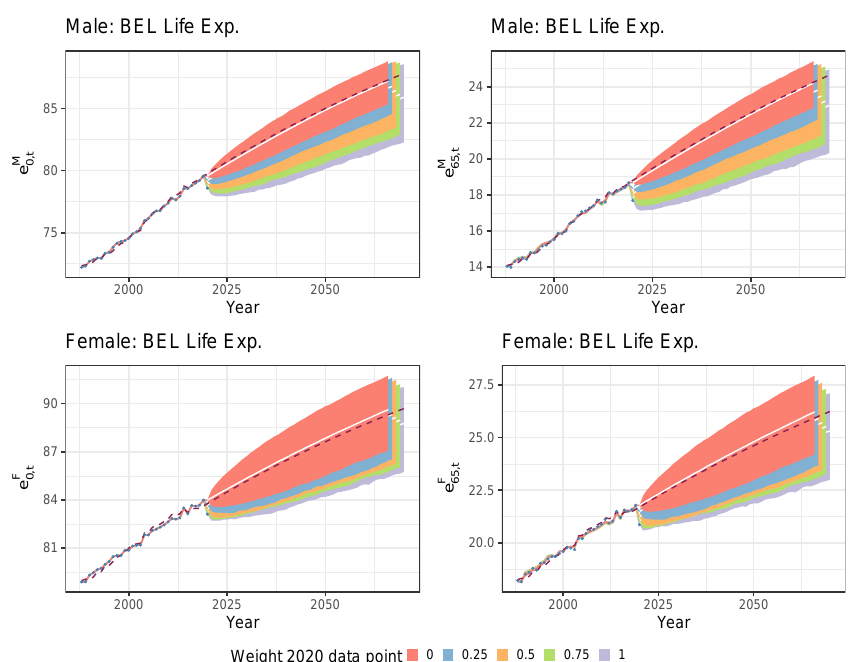
Figure 15. Estimated and projected period life expectancies ˆ e x , t for Belgium. Male ( top ) and female ( bottom ) data, ages 0 ( left ) and 65 ( right ), calibration period 1988–2020, projection period 2021–2070. Calibration and projection is based on the method in Section 5.1. We show the 0.5% quantile, median (white lines) and 99.5% quantile (fan charts), based on 10,000 simulations, across each weighting scenario. The dark red, dashed line shows the 50% quantile originating from the original IA | BE 2020 model. The blue dots represent the observed period life